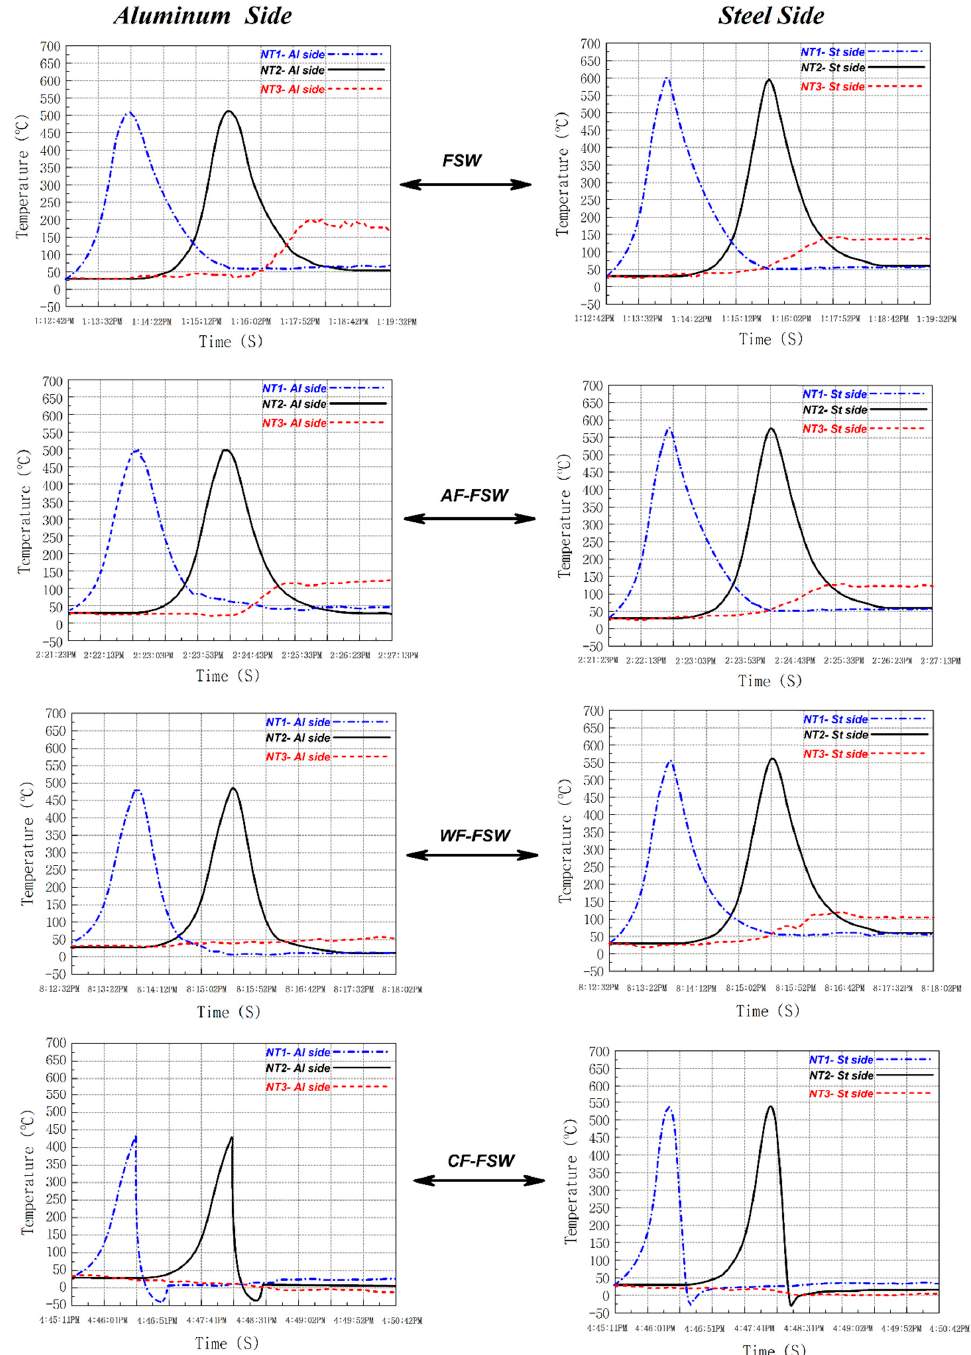
Figure 2. Thermal history of the workpiece according to the time on steel and aluminum side.